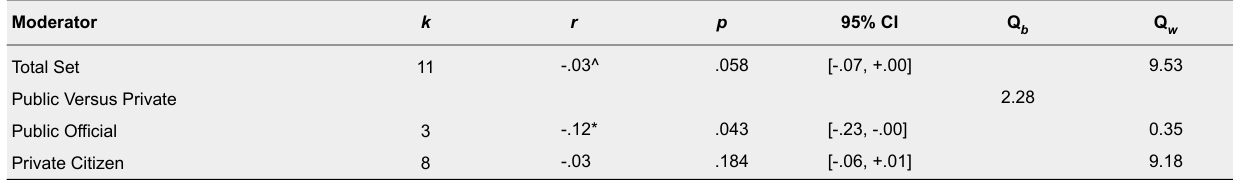
Validity Test 5: Public/Private Sample as a Moderator of the Political Conservatism and Integrative Complexity